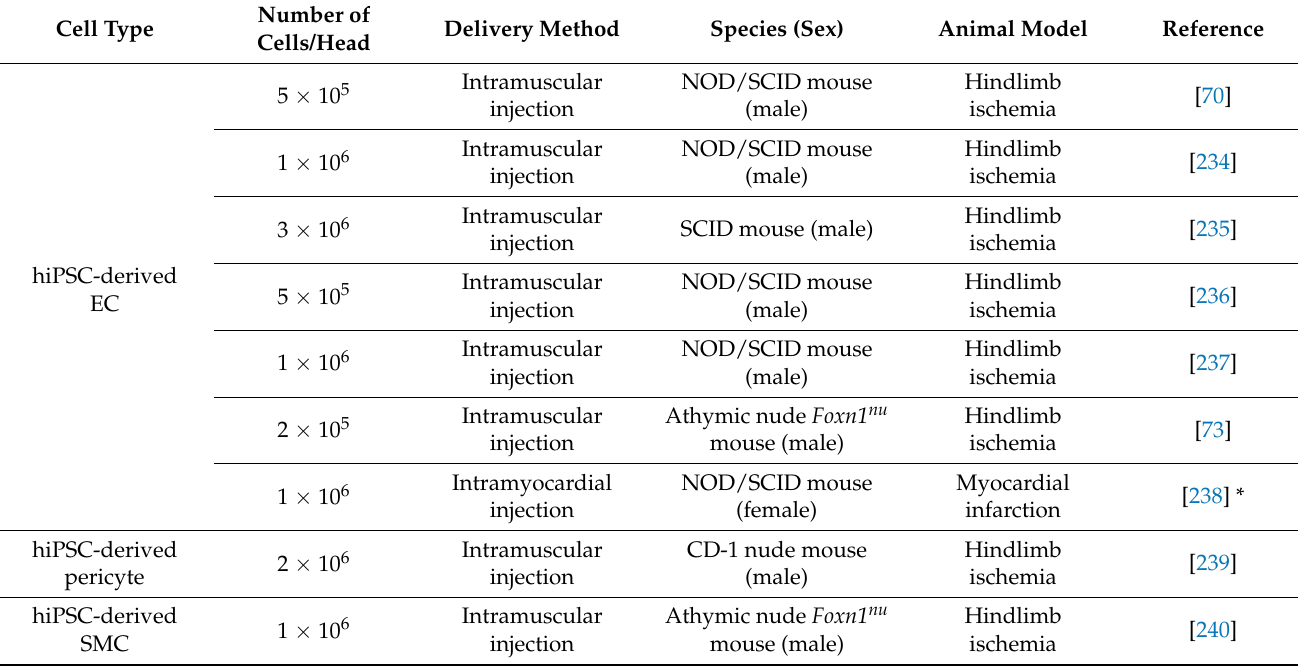
Table 3. Summary on therapeutic applications of hiPSC-derived vascular